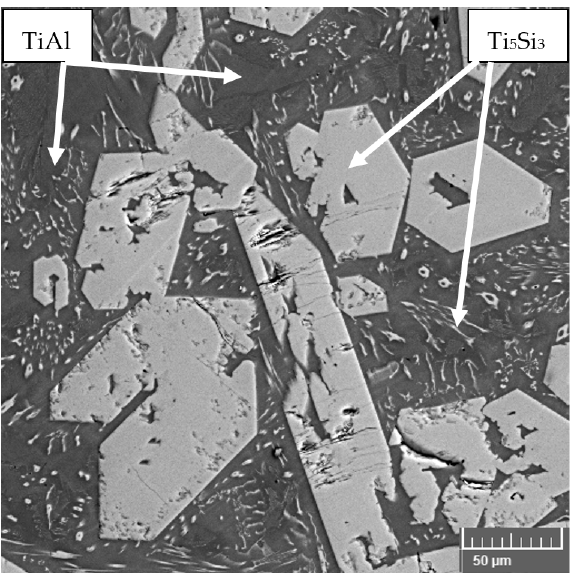
Figure 1. Microstructure of TiAl15Si15 prepared by vacuum induction